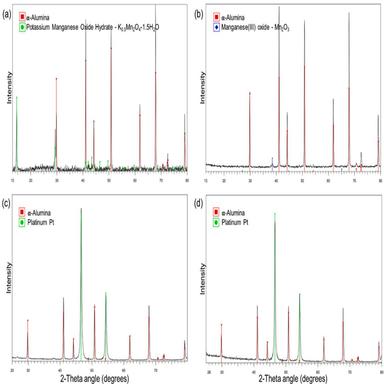
XRD patterns for the prepared catalysts; (a) MnOx on alumina from KMnO4 precursor – 800 ◦C in air, (b) MnOx from MnAc precursor – 800 ◦C in air, (c) Pt on alumina from TAPCl precursor – 800 ◦C in H2, (d) Pt on alumina from H2PtCl6 precursor – 800 ◦C in H2.